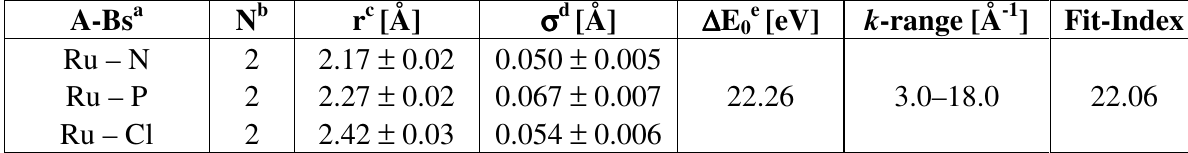
Table 1. EXAFS determined structural parameters of xerogel